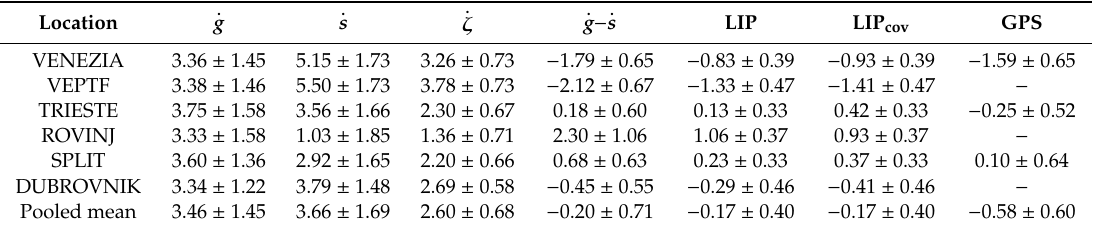
Table 6. Results of calculations using C3S altimetry dataset (1993–2018). Columns are the same as in Table 3. All data are in mm y − 1 .